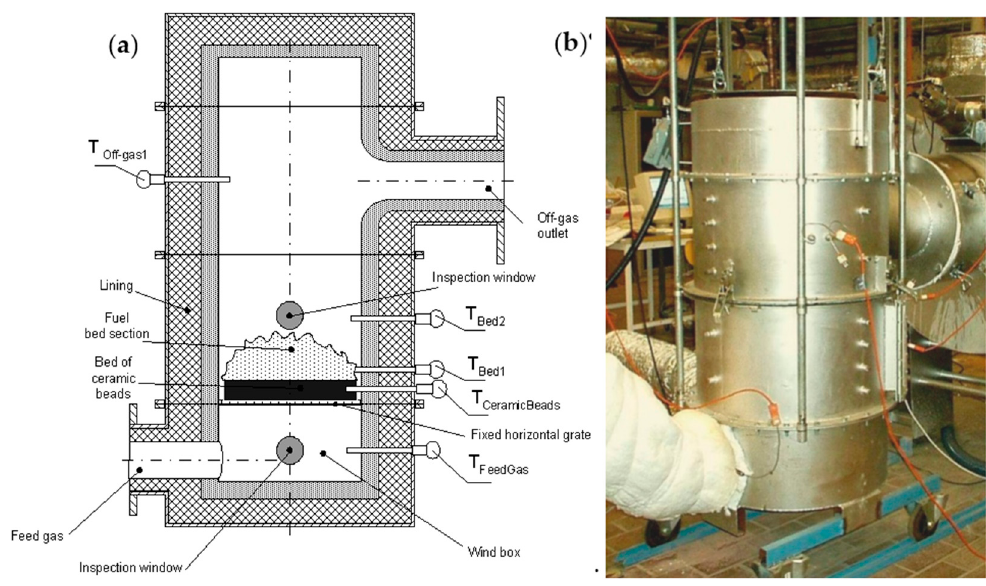
Figure 6. Side view of an updraft gasifier (T Feed Gas —temperature of preheated feed gas, T Bed1 ; T Bed2 —reacting fixed-bed, fuel gas T Off-gas1 and ceramic beads T Ceramic Beads ) ( a ), and batch type slag reactor HiTAG/HiTSG ( b ).